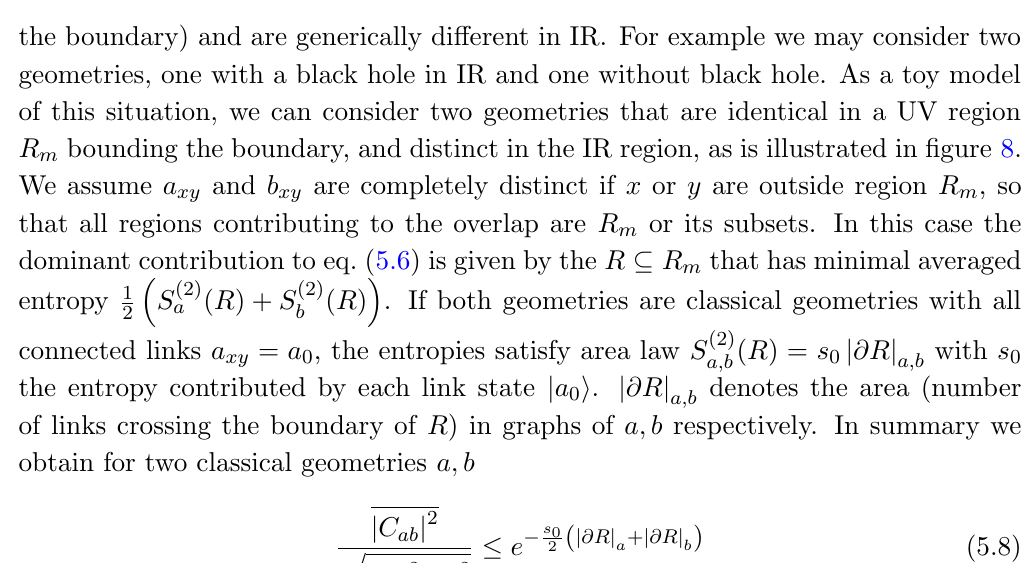
Figure 8 . Two graphs with identical edges in the UV region (grey) and di(cid:11)erent edges in IR (orange) and between the two regions. The overlap of these two states are upper bounded by eq. (5.6), with j @R j = j @R j = a b